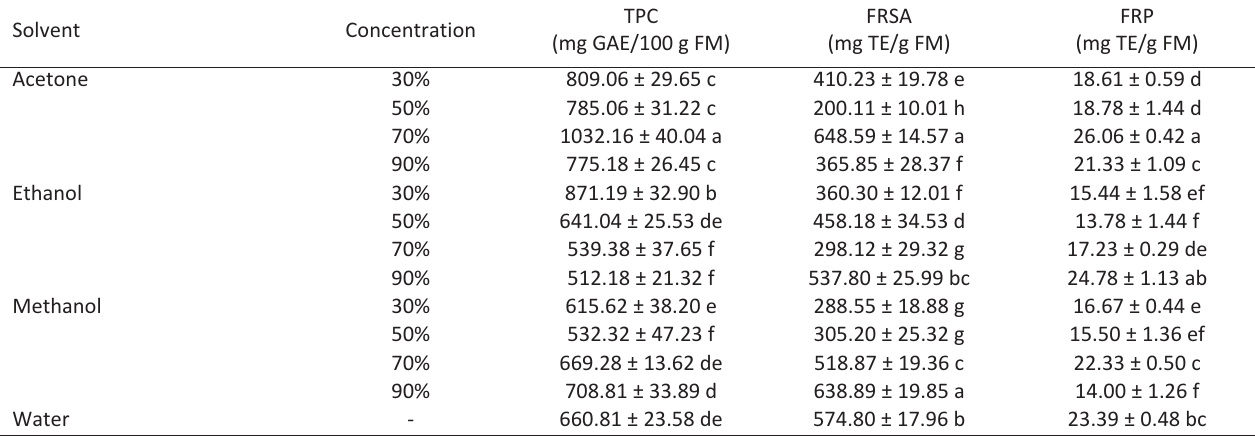
Values are presented as means ± SD of six measurements. Values with different letters are significantly different (p<0.05). n=